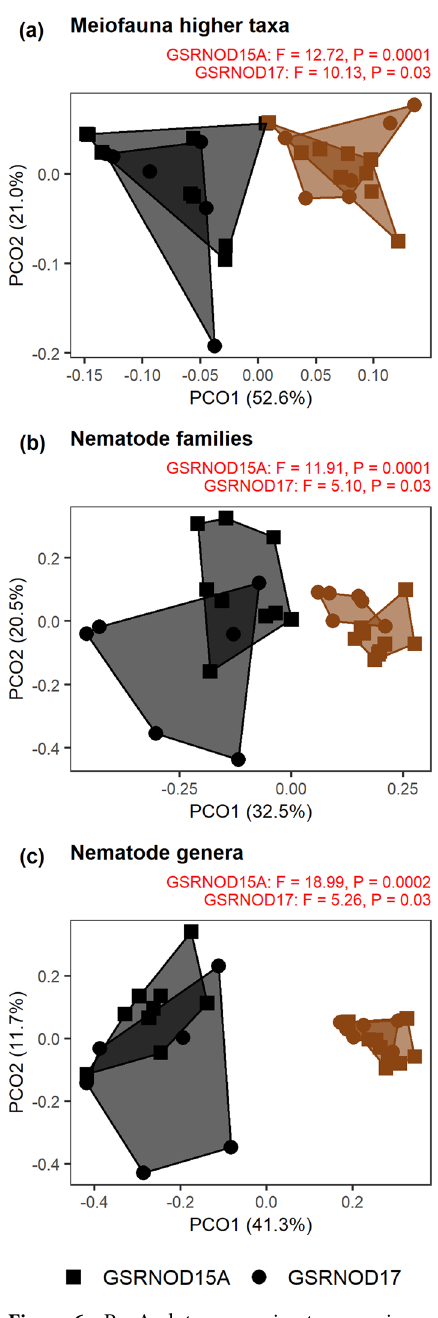
taxa, ( b ) nematode families and ( c ) nematode genera. Convex hulls are drawn around samples from the same substrate and expedition. The F and P-values for the PERMANOVA tests are shown on top of each plot; as all tests were significant, these are all indicated in